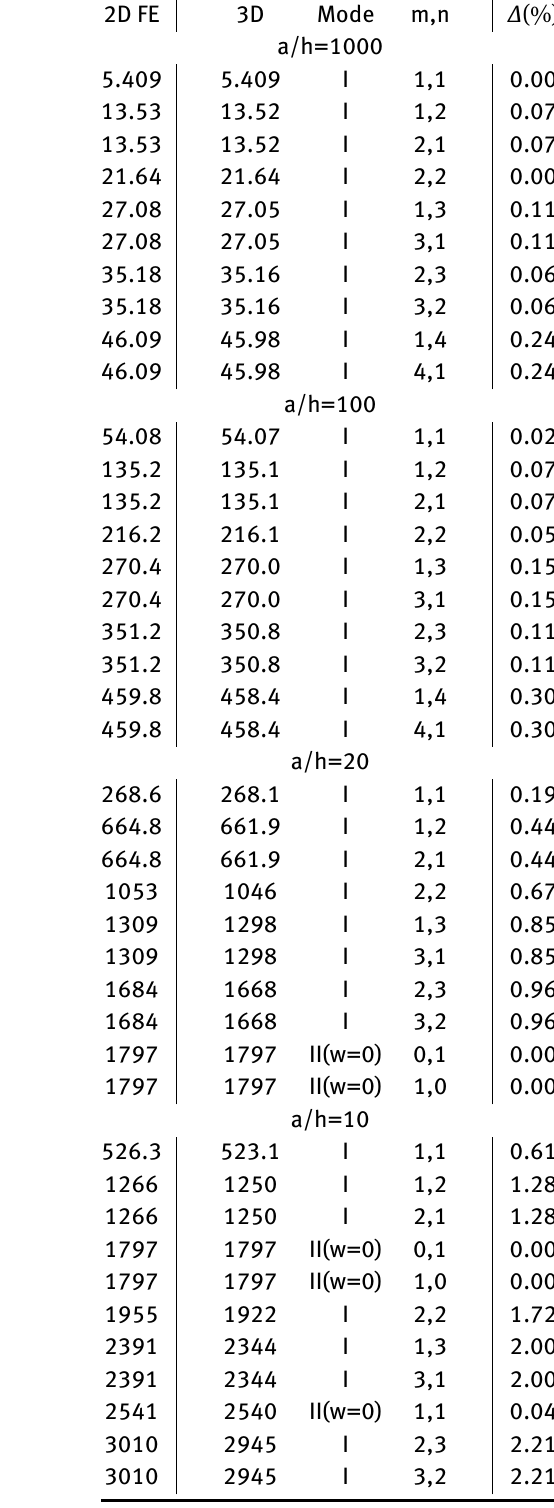
Table 9: Second benchmark, simply supported cylinder made of alu- Table 10: Third benchmark, simply supported plate made of alu- minium alloy with thickness ratios R α /h=1000, R α /h=100, R α /h=10 minium alloy and titanium alloy with thickness ratios a/h=1000, and R α /h=5. First ten frequencies in Hz, comparison between the a/h=100, a/h=20 and a/h=10. First ten frequencies in Hz, compar- present 3D exact solution and the 2D FE solution via Nastran. The ison between the present 3D exact solution and the 2D FE error is calculated as ∆ (%) = FE −3 D × 100 . 3 D